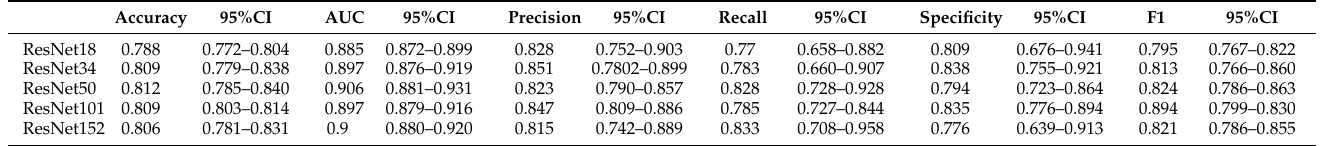
Table 3. Prediction performance of models with hip radiographic images and clinical patient variables.